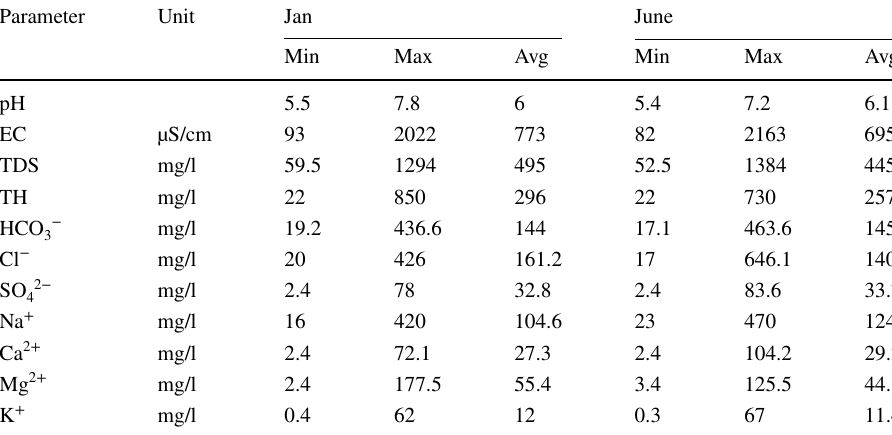
Table 1 Statistics of physico- chemical parameter ( n = 30)